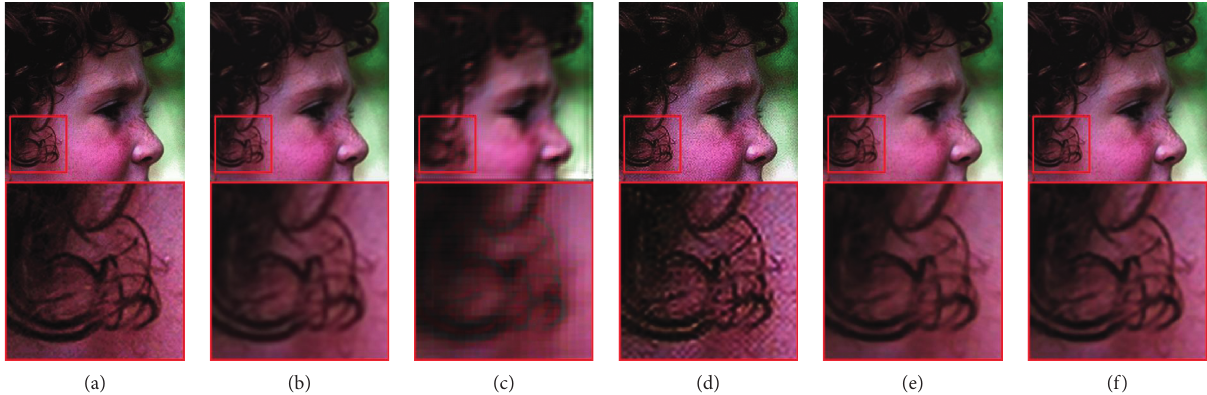
Figure 9: Super-resolution results of “girl” image with magnification factor 2: (a) original high-resolution image; (b) result reconstructed by SRCNN; (c) result reconstructed by FSRCNN; (d) result reconstructed by SRGAN; (e) result reconstructed by RDN; (f) result reconstructed by our method.